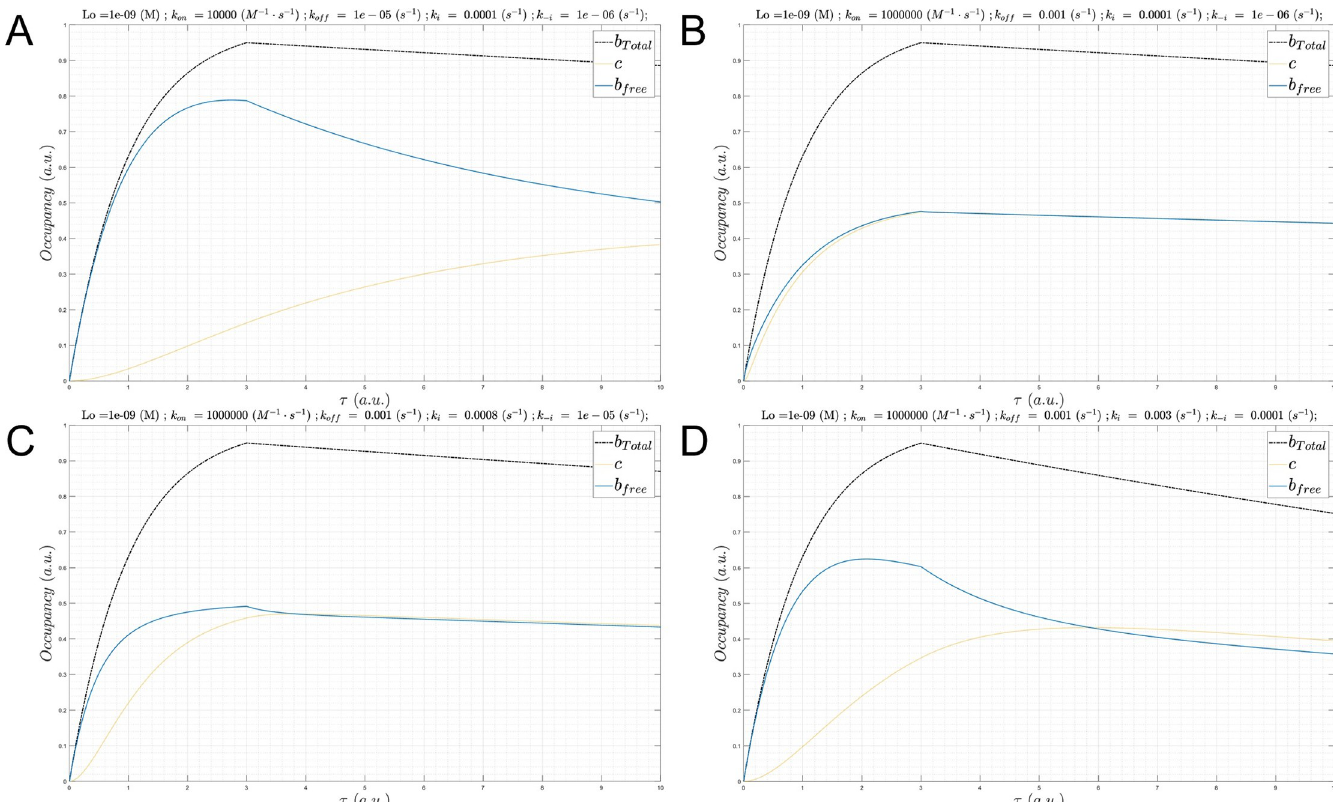
Fig 11. (A) Plot of B total ( τ ) (black), B free ( τ ) (blue), and c ( τ ) (gold) for Λ = 199 hr ( k i = k − i = 1x10 -4 s -1 1x10 -6 s -1 , k and k on = 1x10 4 M -1 s -1 . (B) Same as A, except Λ = 199 hr ( k i = 1x10 -4 s -1 , k − i = 1x10 -6 s -1 , k approximate SSO is achieved at this k A, except Λ = 20 hr (